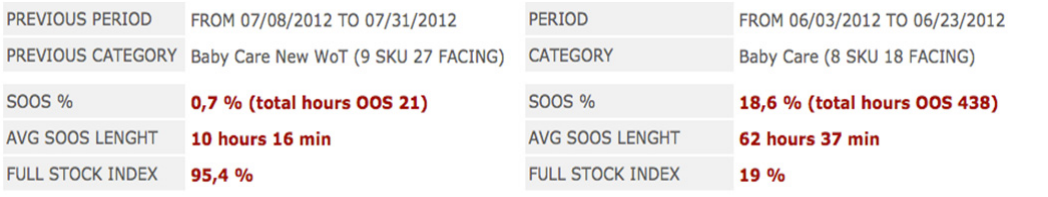
Figure 14. Comparison between time periods considering two categories of product.